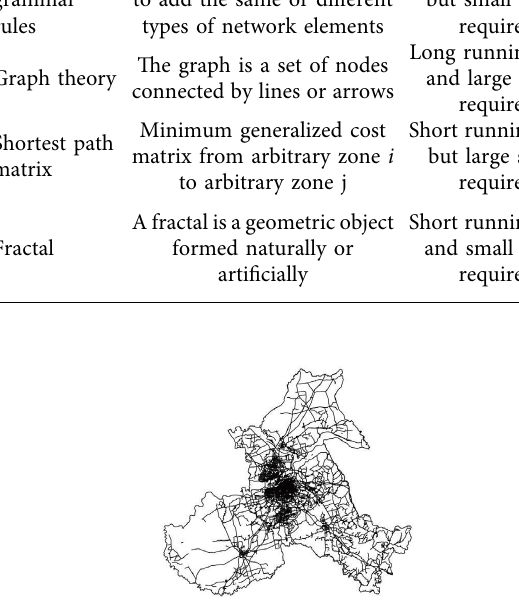
Figure 2: Harbin’s road